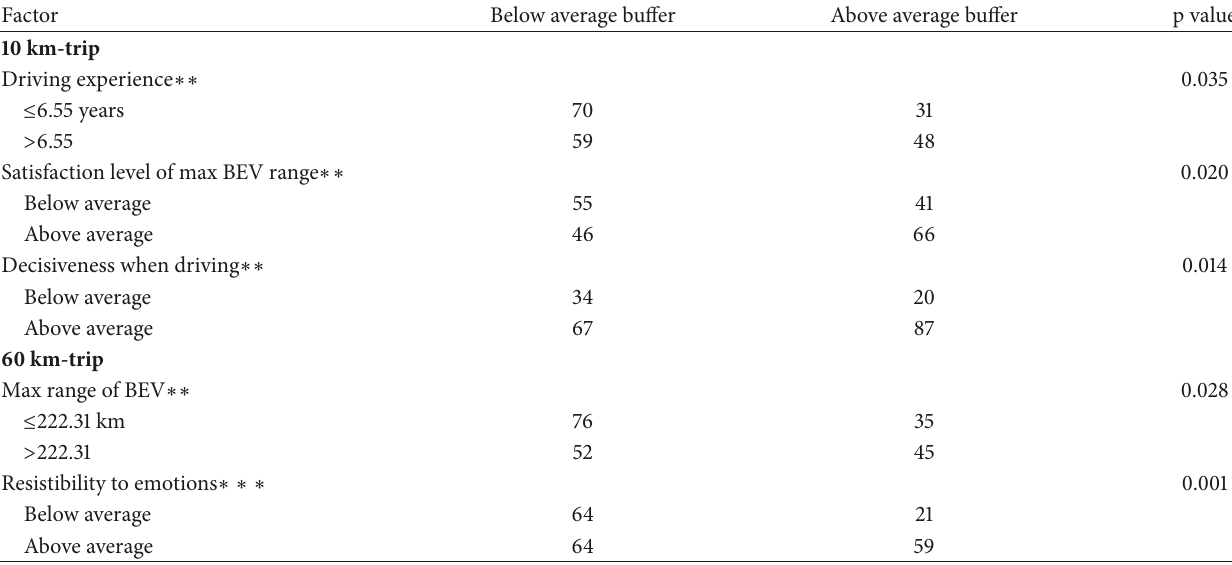
Table 6: Chi-square test results of factors that may be related to safety buffer (10